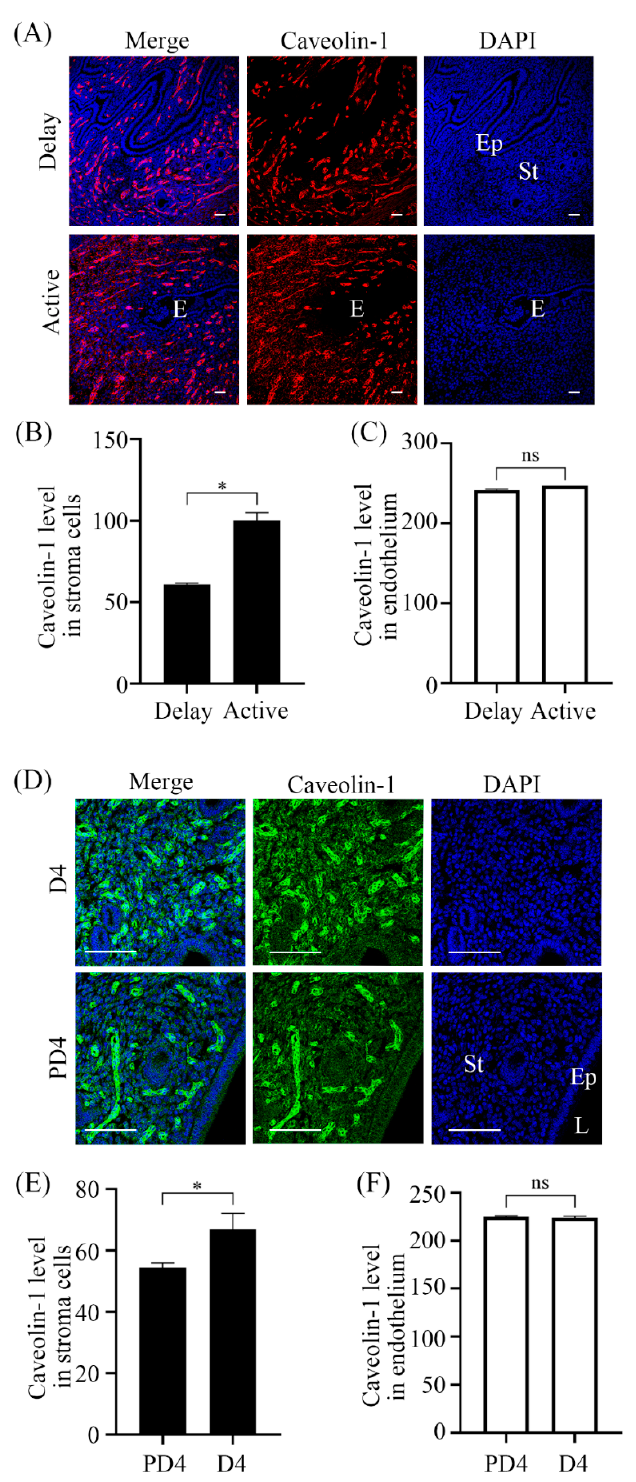
Figure 2. Caveolin-1 immunofluorescence in mouse uteri. ( A ) Mouse uteri under delayed implan- tation and activation, respectively. ( B ) Semi-quantitative Caveolin-1 level in endometrial stromal cells in ( A ). ( C ) Semi-quantitative Caveolin-1 level in endothelium in ( A ). ( D ) Mouse uteri on day 4 of pregnancy and day 4 of pseudopregnancy. ( E ) Semi-quantitative Caveolin-1 level in endometrial stromal cells in ( D ). ( F ) Semi-quantitative Caveolin-1 level in endothelium in ( D ). Five mice per group. E, embryo; St, stromal cells; Ep, epithelium; L, uterine lumen. *, p < 0.05; ns, not significant. Scale bar = 100 μ m.